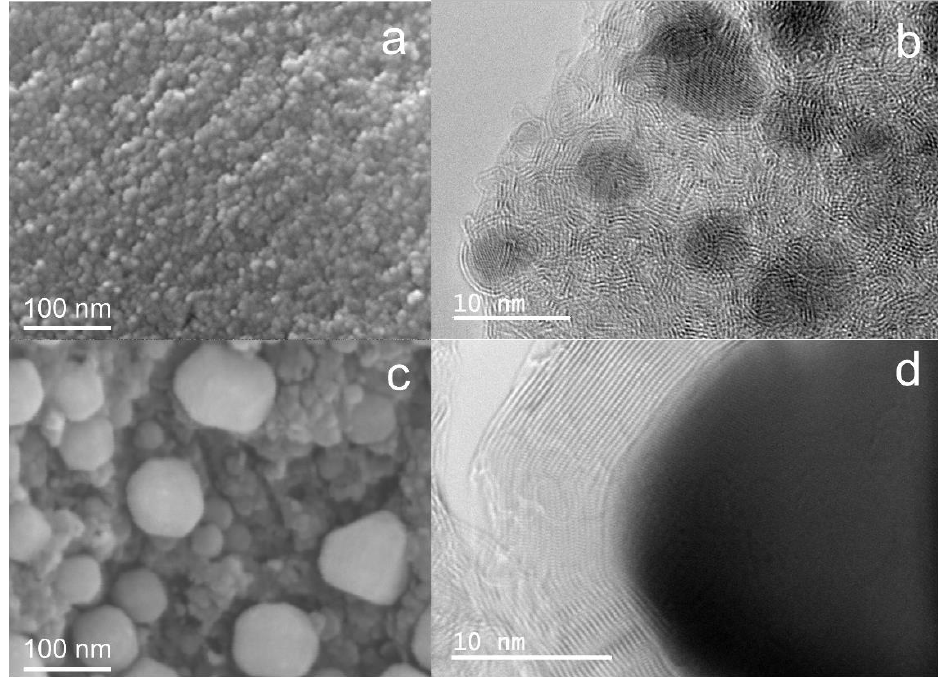
Figure 3. SEM and HRTEM images of GEINs embedded in the carbon matrix ( a , b ) and GEINs distributed on the outer surface of the carbon matrix ( c , d ).